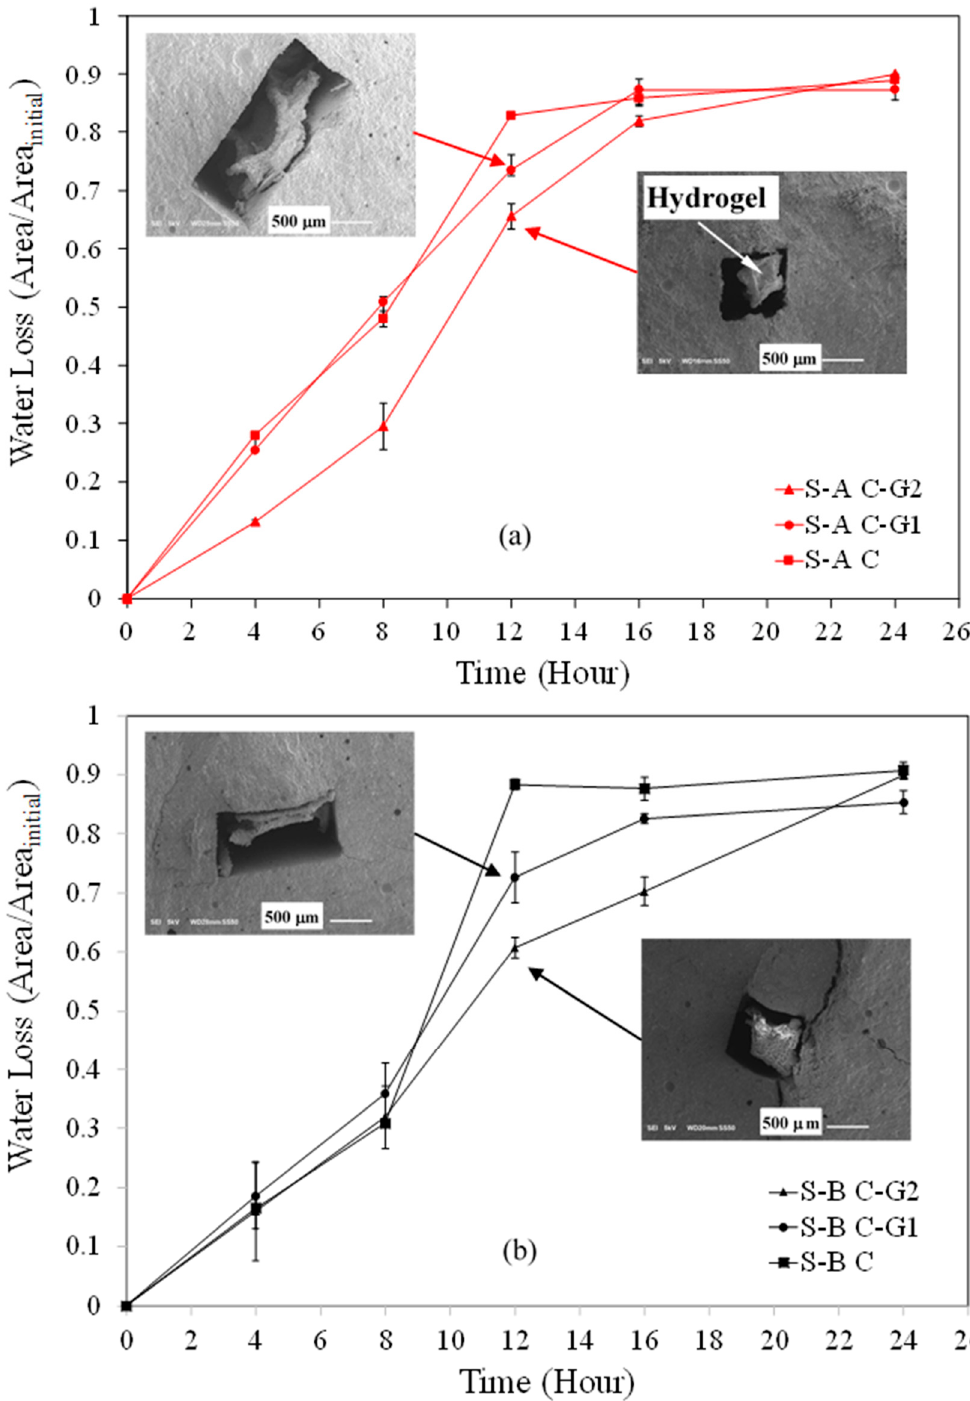
Figure 5. Water loss of ( a ) S-A and ( b ) S-B embedded in different pastes. Micrographs of embedded SAPs at the age of 12 h in C-G1 and C-G2 pastes are presented.